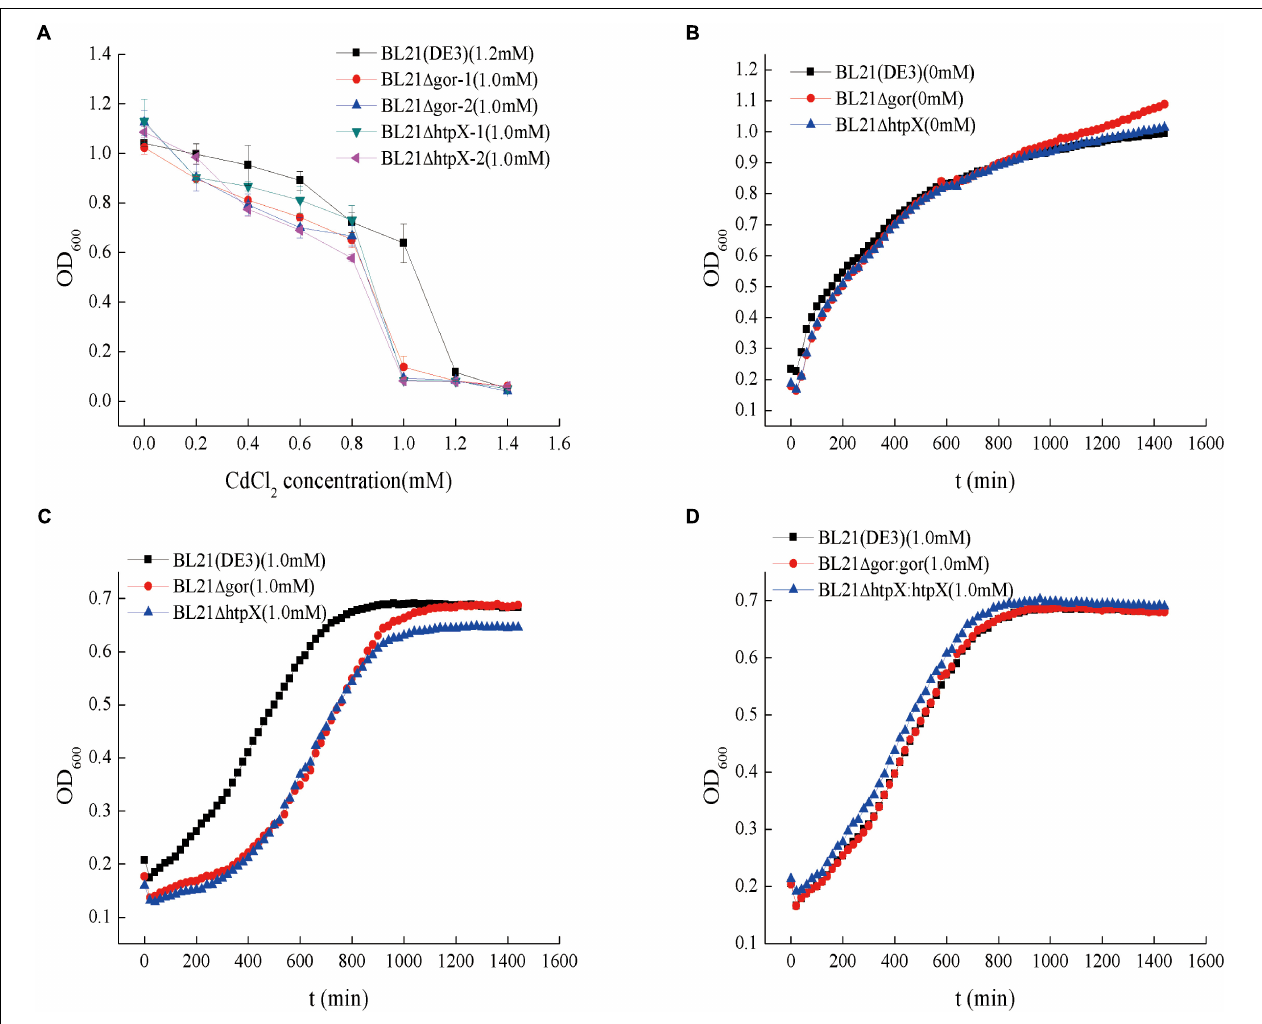
FIGURE 5 | Cadmium resistance capacities and growth curves of knockout strains and plasmid remedial strains. The symbol “ (cid:49) ” represents gene knockout. (A) Cadmium resistance capacities of the knockout strains, with BL21 as a control; BL21 (cid:49) gor-1 and BL21 (cid:49) gor-2 represent gor knockout strains. The 0.8 and 1.0 mM represent the cadmium MIC values. (B) Growth curves of the knockout strains without cadmium pressure. (C) Growth curves of the knockout strains with 1.0 mM cadmium ions. (D) Growth curves of the plasmid remedial strains with 1.0 mM cadmium ions. For the cadmium MIC assay (A) , 10- µ L aliquots of overnight cultures of highly cadmium-resistant strains were transferred into 96-well plates (each well contained 1,000 µ L of LB medium); for the growth assay (B–D) , 6- µ L aliquots of overnight cultures were diluted into 100-well plates containing 350 µ L of LB medium. The OD 600 of the cell was measured with the instrument Bioscreen C every 20 min. The growth curve was the average value of 10